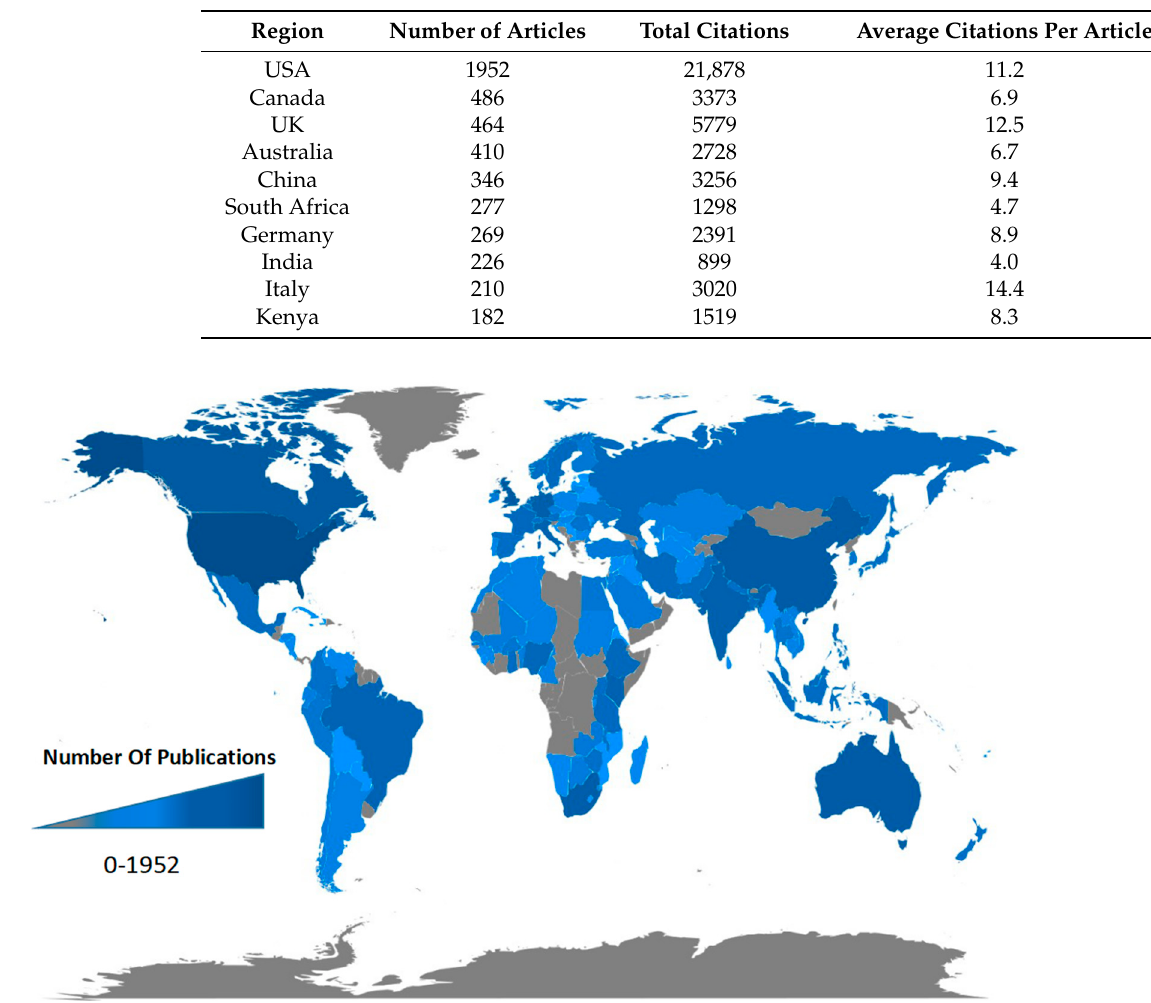
Table 2. Top 10 highly producing countries in food security research.